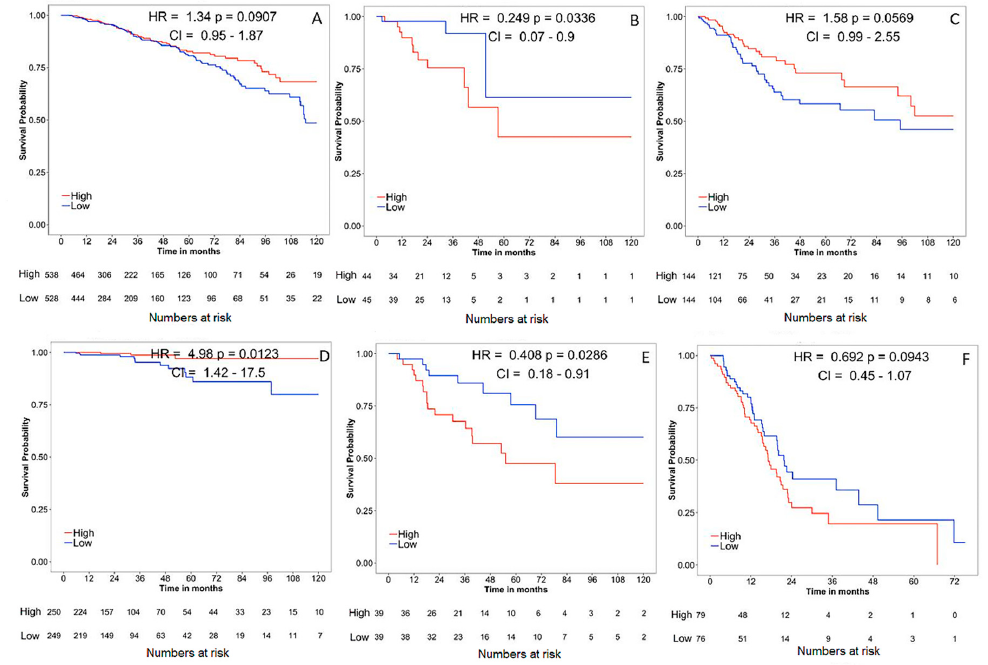
Figure 4. Survival analysis of CLDN-1 in various cancers. The red line denotes higher expression, and the blue line indicates lower expression. ( A ) Breast invasive carcinoma (BRCA); ( B ) rectum adenocarcinoma (READ); ( C ) cervical squamous cell carcinoma and endocervical adenocarcinoma (CESC); ( D ) thyroid carcinoma (THCA); ( E ) adrenocortical carcinoma (ACC); ( F ) pancreatic adenocarcinoma (PAAD).